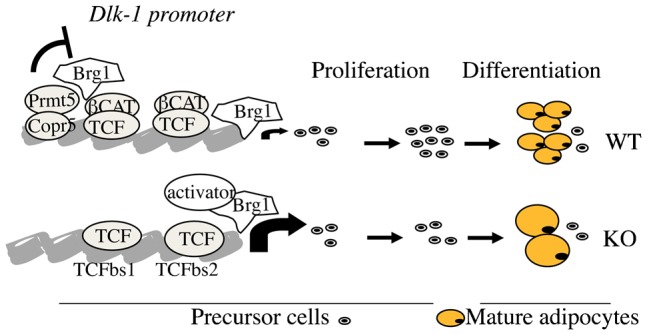
Schematic diagram recapitulating the transcriptional regulation on the Dlk-1 promoter.See Results and Discussion for explanations.